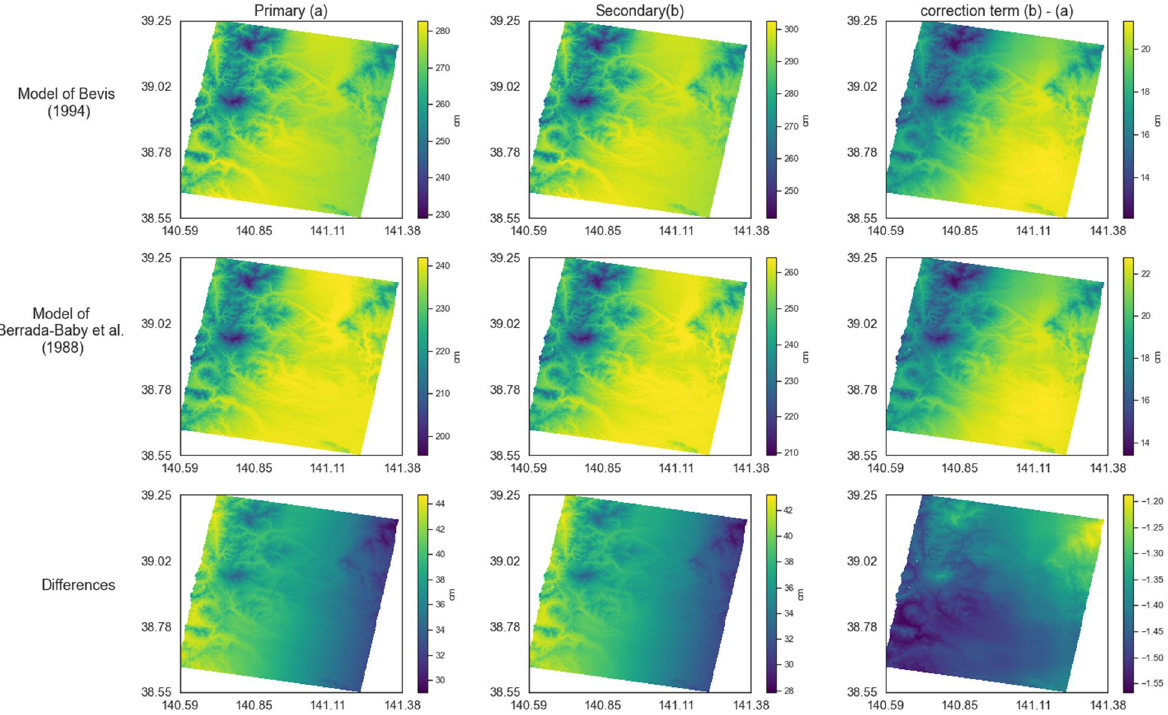
Fig. 5 Examples of tropospheric delay predicted in the Tohoku region obtained using the slant-delay integration method from the refractivity models of Bevis (1994) (top) and Berrada-Baby et al. (1988) (middle) and the difference between the two models (bottom). a Delay predicted for the primary image. b Delay predicted for the secondary image. c Correction term calculated by subtracting the delay on the two acquisition dates. The acquisition dates are identical to those shown in Fig. 4